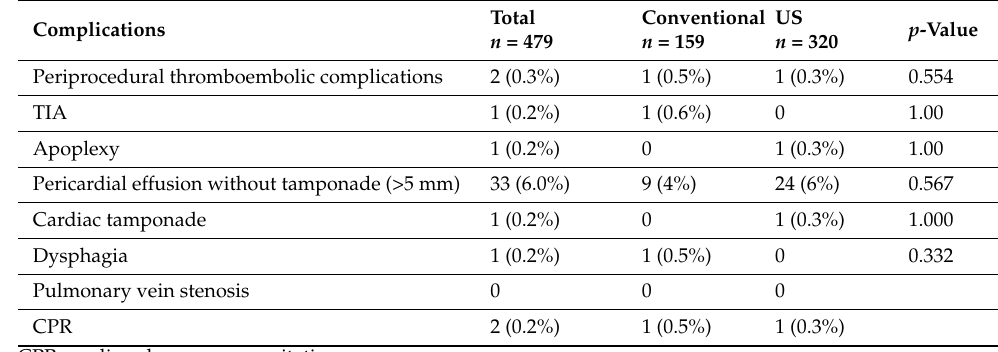
Table 6. Peri-/postprocedural in-hospital thromboembolic and other